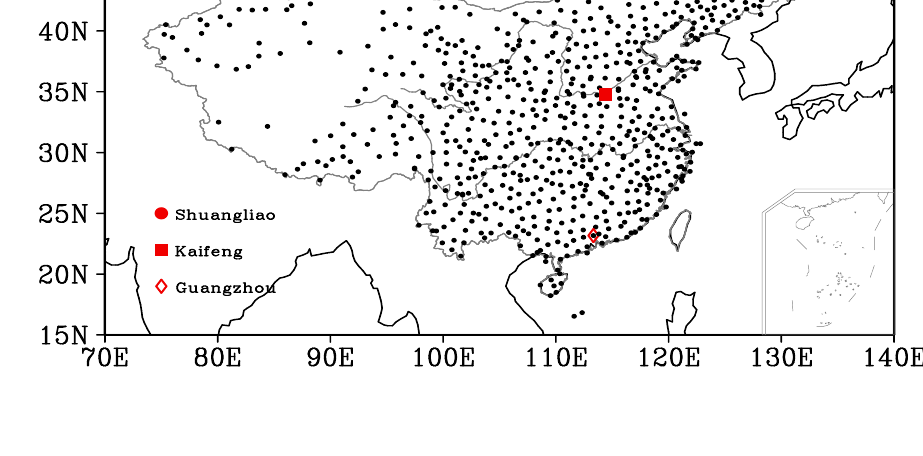
Fig. 1 Spatial distributions of 724 meteorological sites in China (Black dots) (Red marks are for three selected stations)